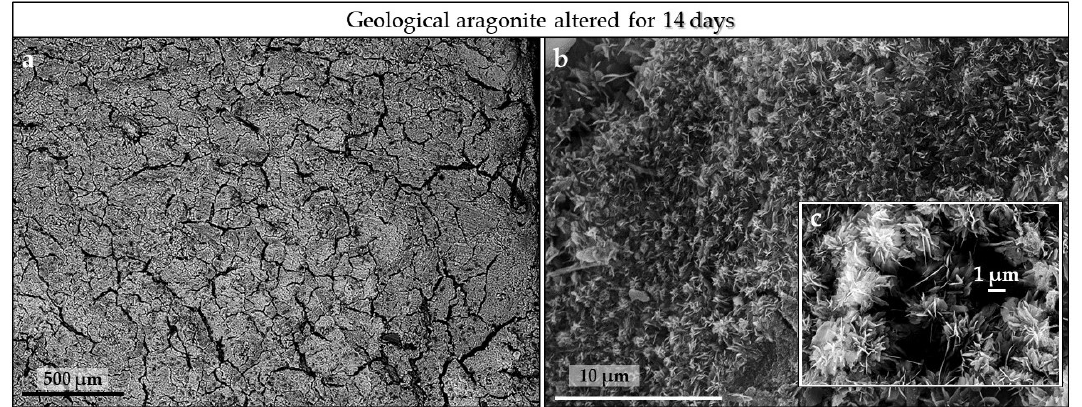
Figure A4. FE-SEM images of geological aragonite transformed for 14 days.